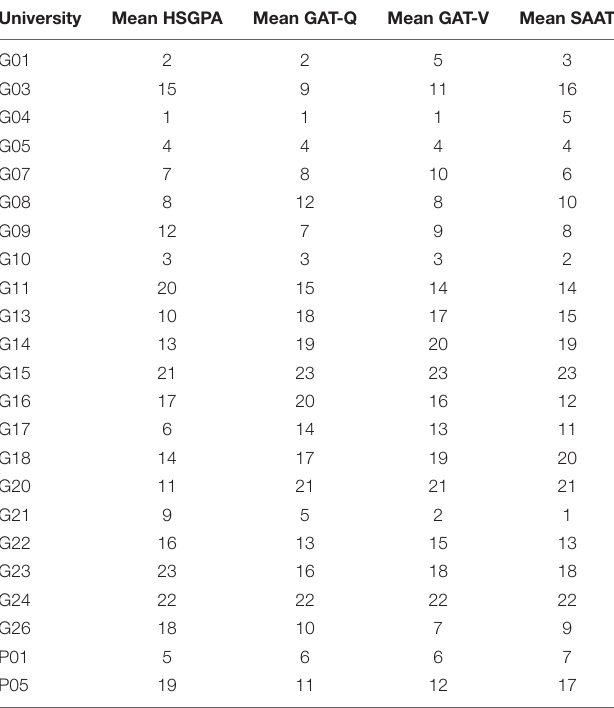
TABLE 2 | University rankings based on the means of pre-university